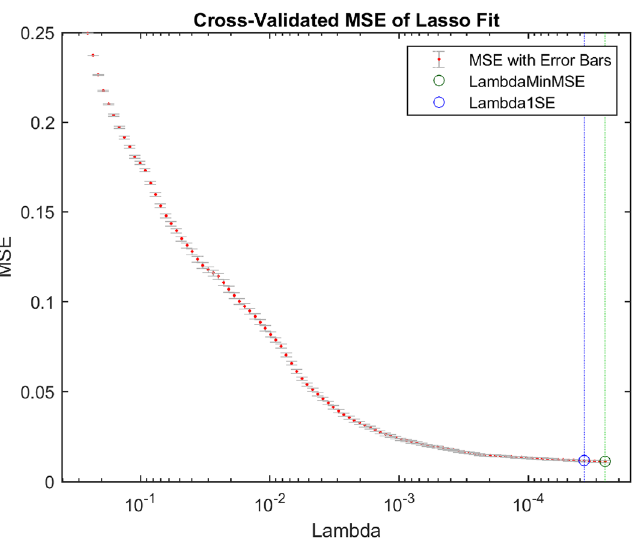
Figure 9. The LASSO fit using the DFs of the conv5